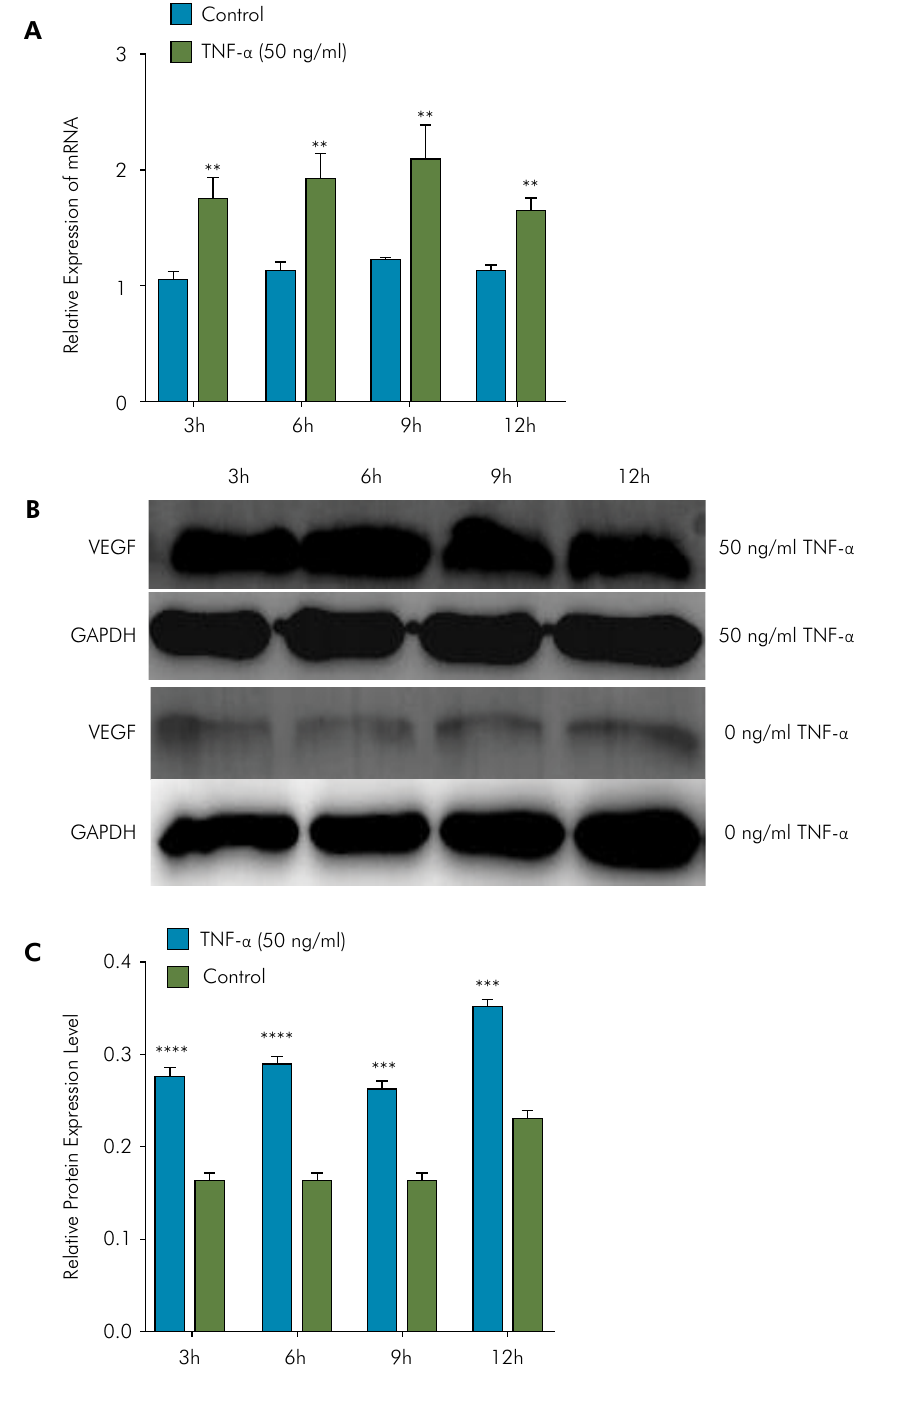
Figure 3. TNF- α promoted the expression of VEGF mRNA and protein. (A) Relative expression levels of VEGF under the action of 50 ng/ml TNF- α at different time points, detected by real-time PCR. Values are normalized to GAPDH expression (** P < 0.01). (B) Western blotting showing positivity for VEGF protein expression in the co-culture system with 50 ng/ml TNF- α . VEGF expression was upregulated under the action of TNF- α at 3, 6, 9, and 12 h. Electrophoresis was performed on 15% polyacrylamide gel, and the density of each band was measured and normalized to that of GAPDH. (C) Relative protein expression levels of VEGF were increased in the experimental groups compared with the control groups. Experiments were repeated at least three times. Values are expressed as means ± standard deviations. (***p < 0.001, ****p <